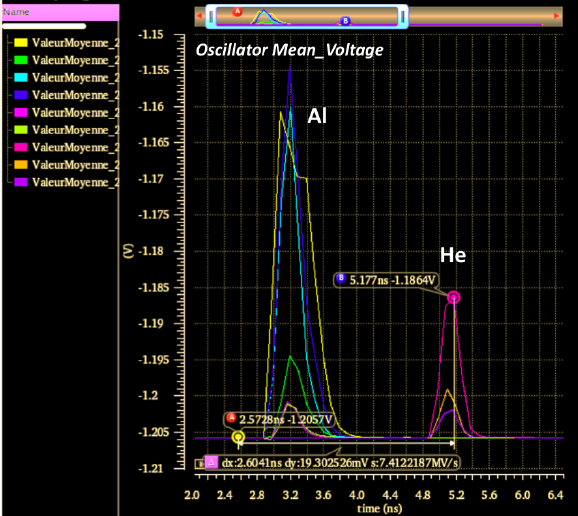
Fig. 18. Mean voltage for the highest currents: aluminum on the left, alpha on the